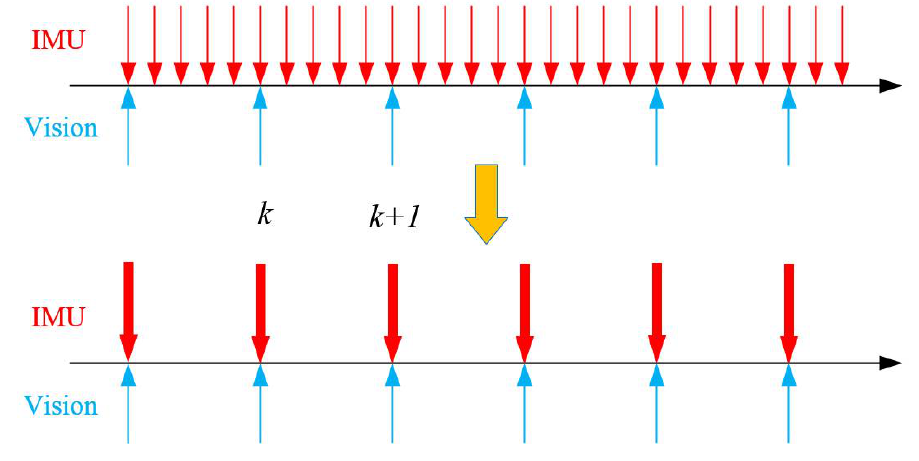
Figure 2. IMU pre-integration diagram .